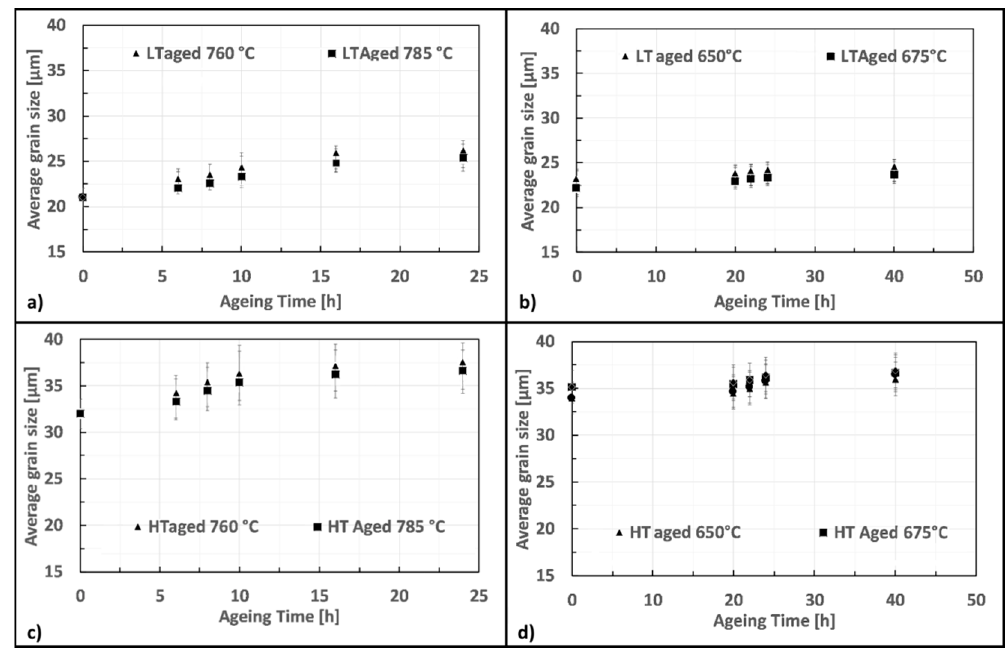
Figure 8. Effect of first and second aging on grain growth for LT and HT specimens: a ) first Figure 8. E ff ect of first and second aging on grain growth for LT and HT specimens: ( a ) first aging on aging on LT, b ) second aging on LT, c ) first aging on HT and d ) second aging on HT. LT, ( b ) second aging on LT, ( c ) first aging on HT and ( d ) second aging on HT.